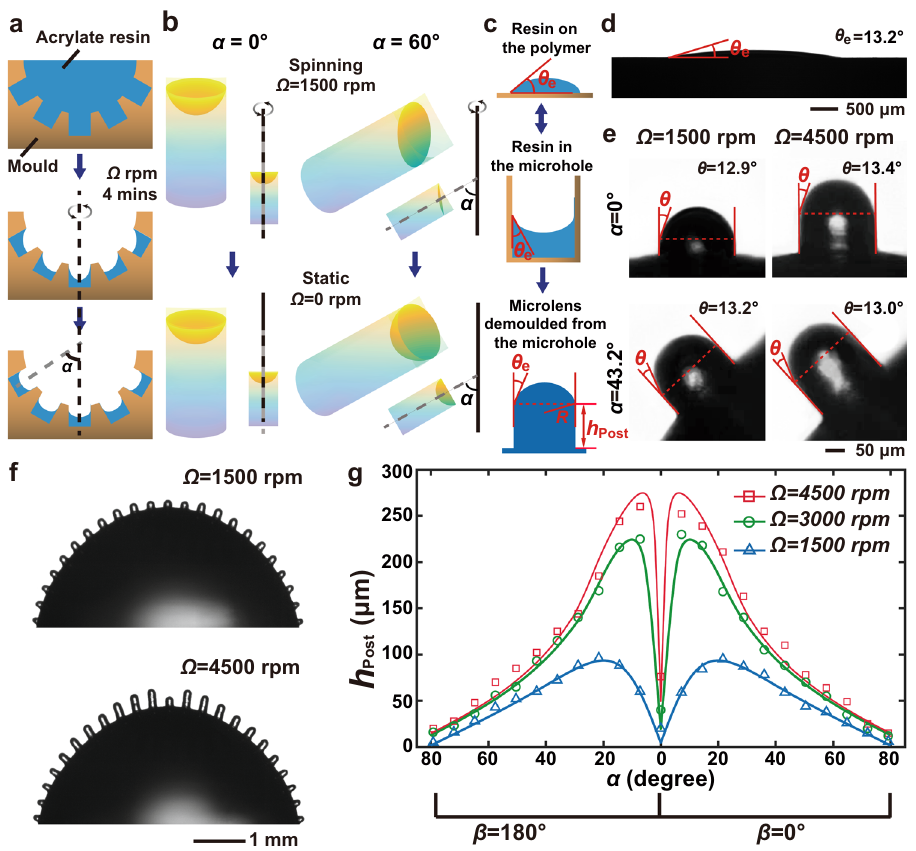
Fig. 2 Design of the mould and morphologic characterization of the BAC-eye. a Illustration showing the fabrication of the mould. b The surface pro fi les of the acrylate resin in the microholes in different orientations during dynamic (while spinning) and static (after spinning) equilibrium. c A comparison between the surface pro fi les of the acrylate resin on the (top) fl at polymer substrate, (middle) in the microhole, and (bottom) after the microlens is demoulded from the microhole. d Contact angle measurements for the acrylate resin on the photosensitive polymer. e Microscope images of the arti fi cial ommatidia. The microlenses in the different orientations and as produced under different spin rates have a uniform curvature. f Images of a single row of the ommatidia along the curved surface of the BAC-eye. Different heights are produced based on the location of the posts and the balance of forces during the fabrication process. g Experimentally measured (data point markers) and simulation results (solid curves) of the post height distribution across the surface of the hemisphere, with respect to rotational